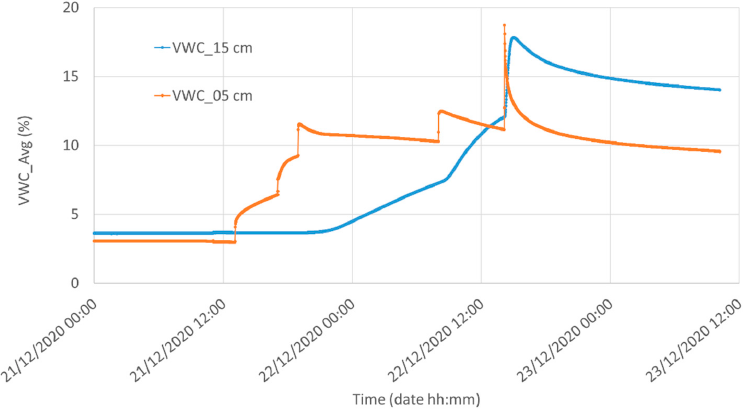
Figure 15. Water content measured by the reference system at two different depths in Loamy Sand: orange, 5 cm underground, and blue, 15 cm underground.